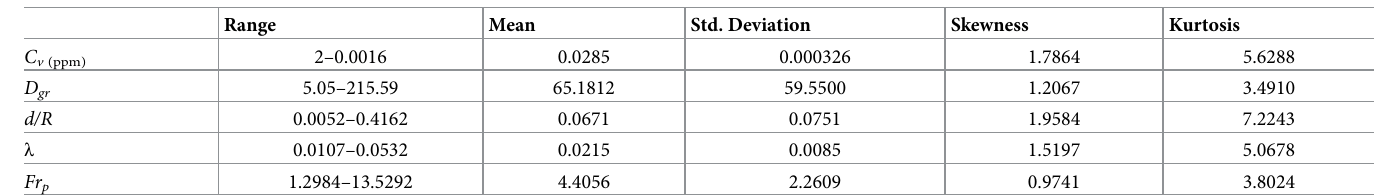
Table 3. Statistical characteristics of the data used for modeling.